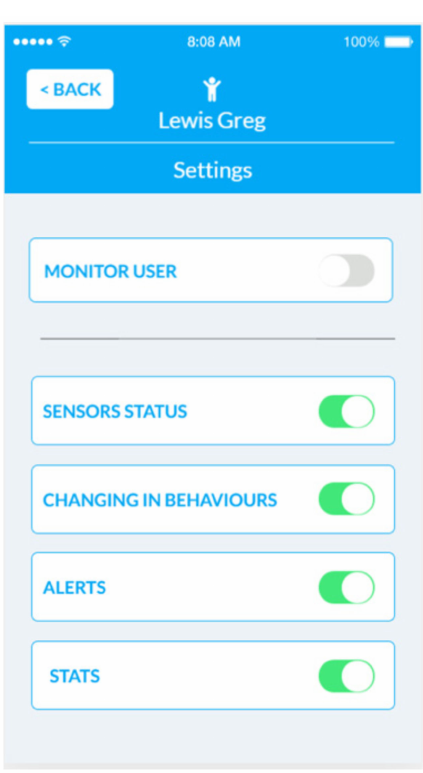
Figure 10. NOAHCare App